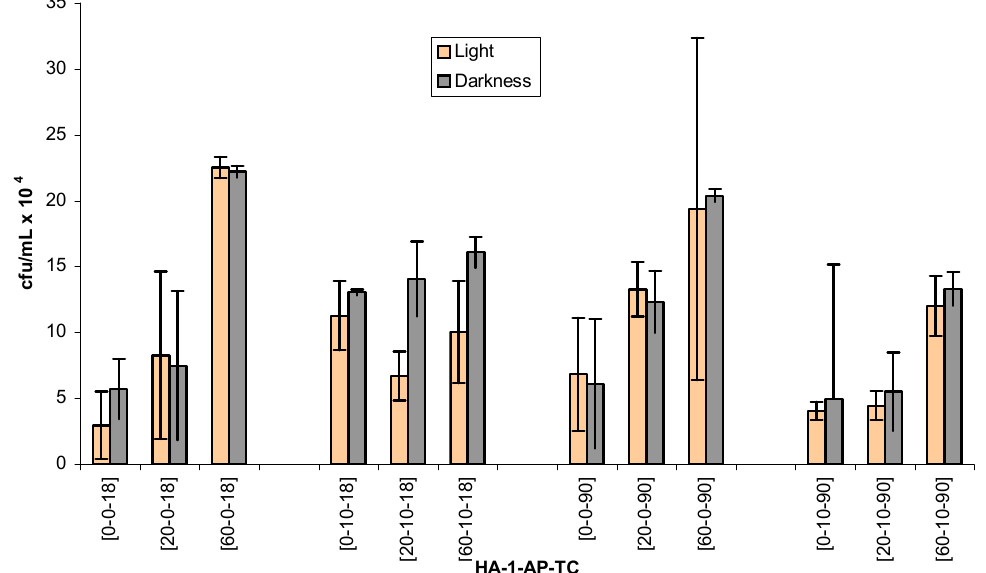
Figure 1. Number of viable heterotrophic bacteria [colony forming units per mililiter (cfu/mL) (±STD)] after exposure to1-AP in sunlight or darkness, in the absence and in the presence of HA, for 18 and 90 minutes. Units for x-axis labels: HA (ppm); 1-AP ( µ M); TC (minutes).